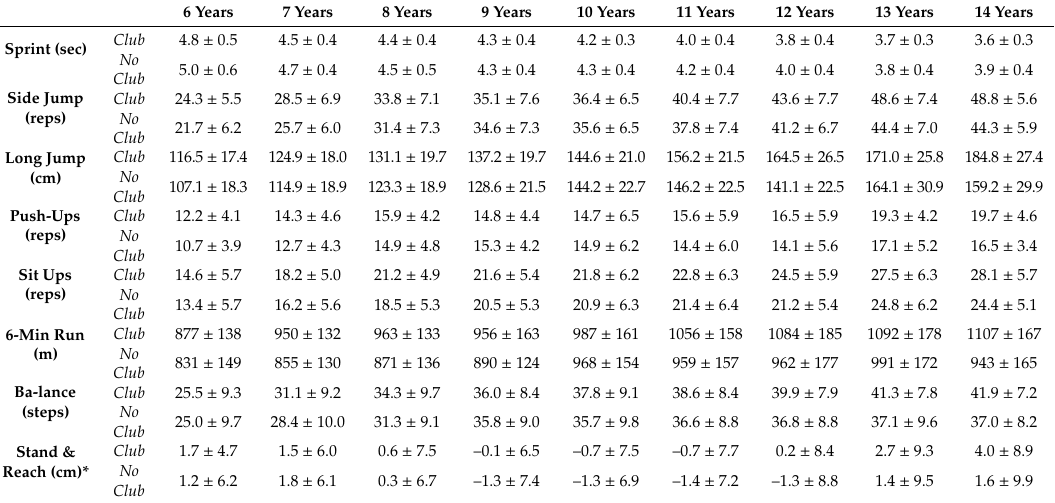
* Negative values indicate poorer performance (not reaching